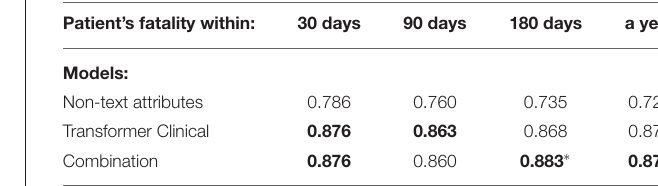
TABLE 14 | Combining the transformer-model with non-text attributes on the patient fatality prediction